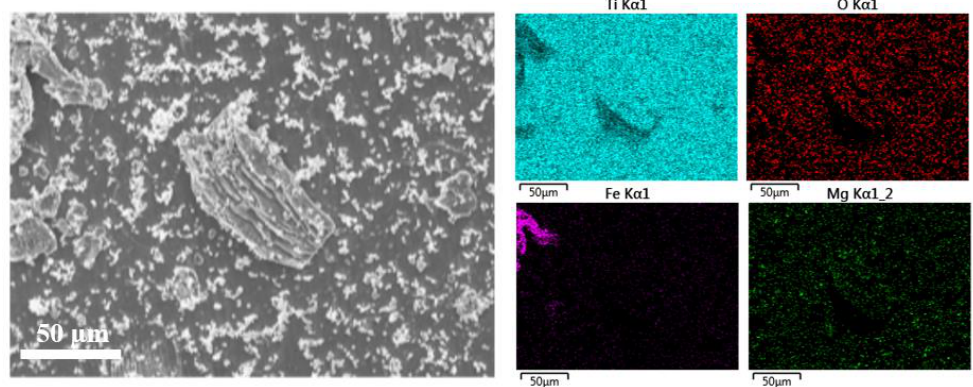
Figure 5. Surface analysis result of external Ti scrap using FE-SEM and EDS mapping analysis.